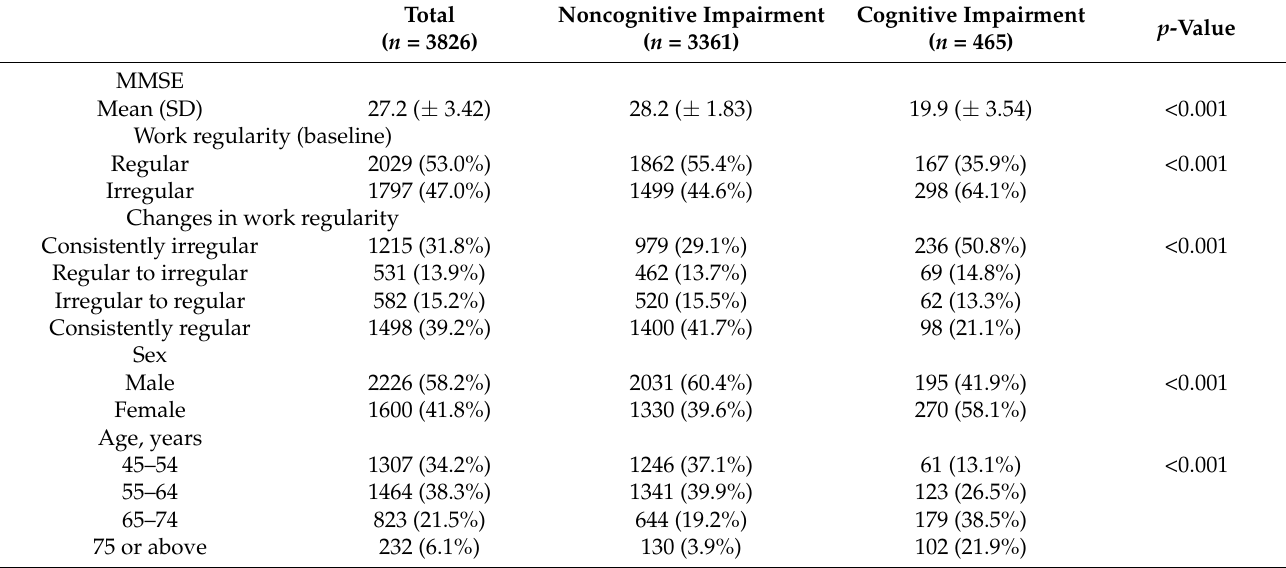
Table 1. General characteristics and cognitive impairment status of the study population at